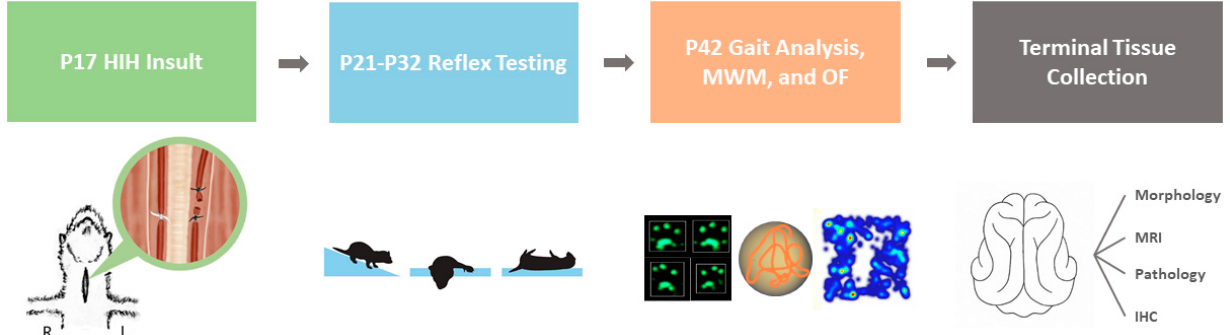
Figure 6. P17 Model Timeline. On P17, animals were administered 3 mg/kg LPS before undergoing bilateral carotid artery ligation, with the RCA occlusion being reversed after the gas exposure (hypoxia-hyperoxia-hypoxia). Special care was taken to isolate the artery away from surrounding vessels and nerves. Treatment was then initiated within a 90–120 min time window after the end of the HIH insult. Basic reflexes were assessed from P21 to P32 followed by a battery of late behavioral testing on P42. The brains were then extracted and processed for further evaluation.